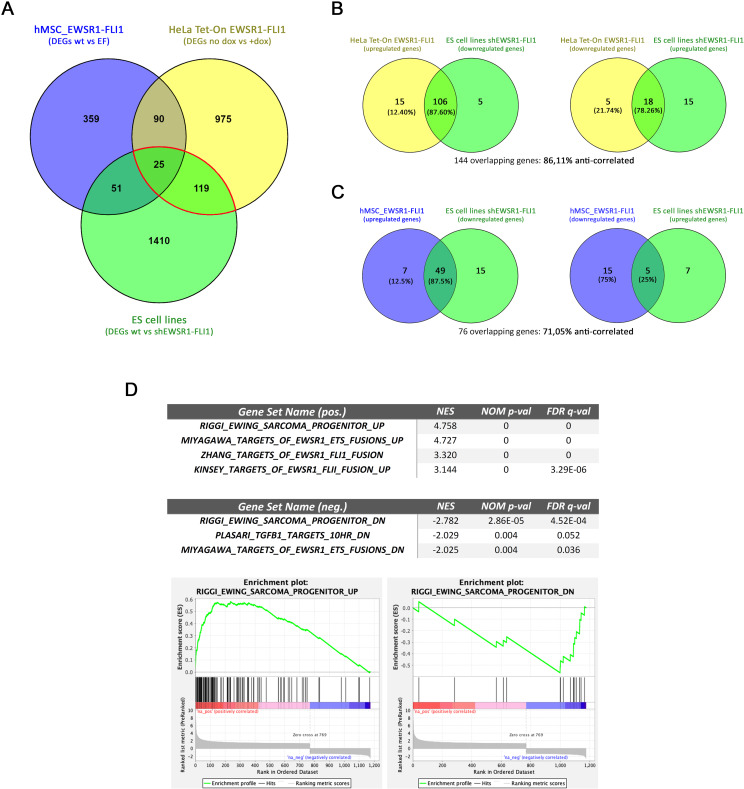
HeLa Tet-On EWSR1-FLI1 gene expression patterns correlated with different published models.A. Venn diagram analysis of differentially expressed genes between HeLa Tet-On EWSR1-FLI1, hMSC_EWSR1-FLI1 and the ES cell line shEWSR1-FLI1. B. Venn diagrams showing the overlap between upregulated genes in the HeLa model and downregulated genes in ES cell lines shEWSR1-FLI1 (and vice versa). C. Overlapping genes between hMSC_EWSR1-FLI1 and shEWSR1-FLI1 ES cell line models are shown in analogous Venn diagrams. D. MSigDB analysis of genes that were significantly and at least 1.3-fold repressed or induced by EWSR1-FLI1 ectopic expression in HeLa cells shows marked overlap with EWSR1-FLI1 target genes (top). The enrichment plots with the best enrichment score are shown as |NES| (bottom). NES, the normalized enrichment score.